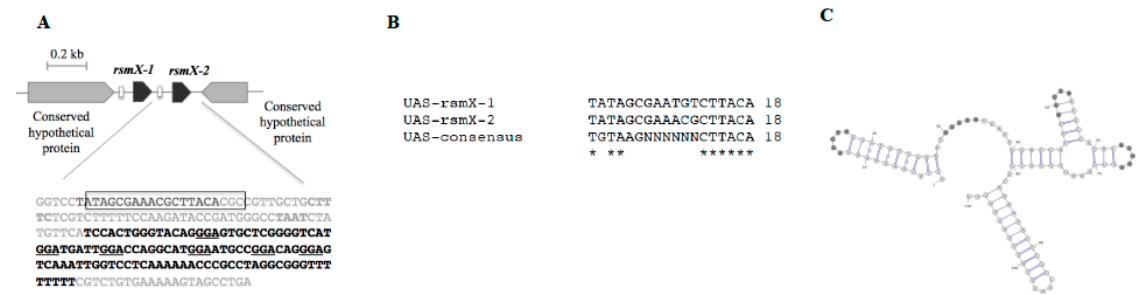
Figure 1. rsmX -2 identification and predicted structure. ( A ) Organization of the rsmX-1 and rsmX-2 genomic region of P. brassicacearum . The upstream activating sequence (UAS) of the GacA protein is represented within the box. GGA motifs involved in the sequestration of RsmA/E proteins are underlined. The transcriptional start has been determined by 5 ′ RACE method. rsmX-2 gene sequence is indicated in bold; ( B ) Alignment of rsmX-1 and rsmX-2 UAS sequence; ( C ) rsmX-2 secondary structure predicted using RNAfold and visualised using vaRNA.